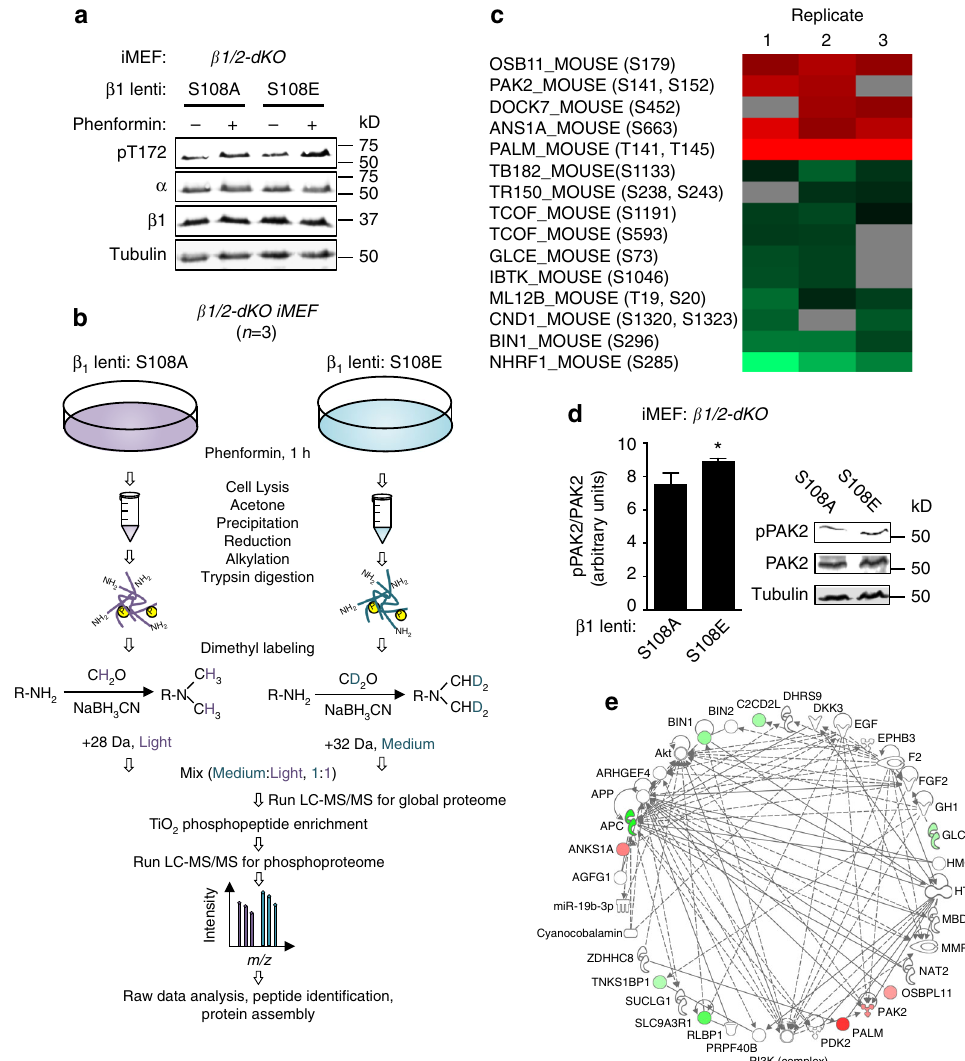
Fig. 2 Quantitative global and phosphoproteomic analysis uncovers cellular roles for β 1-pSer108. a Representative immunoblots for β 1/2-dKO iMEFs-expressing β 1 mutants S108A or S108E, stimulated with 2 mM phenformin for 1 h. b Work fl ow showing the stable isotope dimethyl labeling-based quantitative proteomic and phosphoproteomic approach. c Heatmap showing signi fi cantly perturbed cellular phosphoproteins and corresponding phosphosites. Red indicates increased, and green decreased, phosphorylation in β 1-S108E compared to β 1-S108A-expressing cells. Gray indicates missing phosphopeptide in that replicate. d Immunoblot/densitometry analysis con fi rming increased PAK2-Ser141 phosphorylation in β 1-S108E-expressing cells. n = 3, representative immunoblot is shown. Error bars , mean PAK2-Ser141 phosphorylation (arbitrary units) ± s.e.m. Statistical analysis was performed using unpaired two-tailed Student ’ s t -test. * P < 0.05 indicates signi fi cant increase in PAK2-pSer141 in S108E-expressing cells compared to S108A- expressing cells. e ‘‘ Cell cycle, connective tissue development and function, cellular movement ’’ is one of the top networks associated with changes in phosphoproteome between S108A and S108E-expressing iMEFs, as identi fi ed by Ingenuity Pathway Analysis